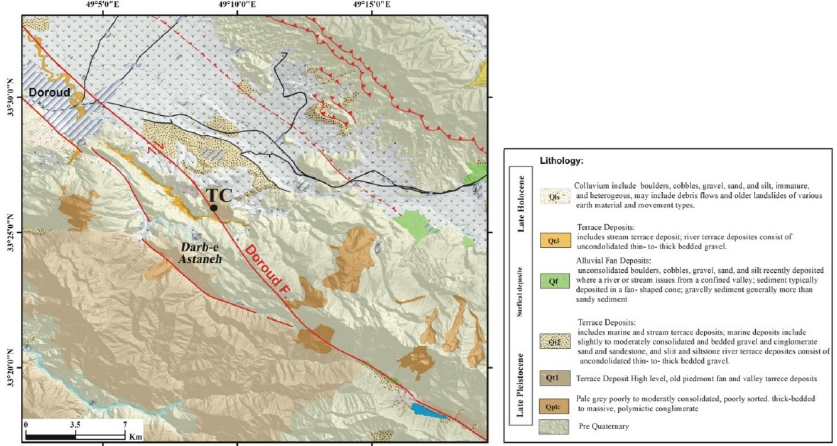
Figure 4. The location of the excavated trench marked with a black circle along the Doroud Fault within the Quaternary deposits.